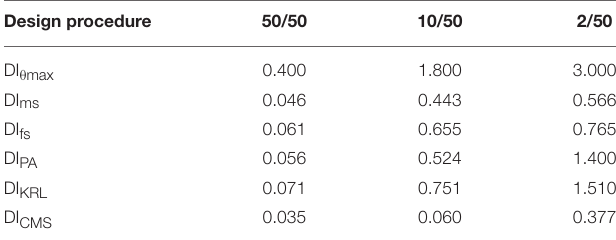
TABLE 2 | Definition of the limit